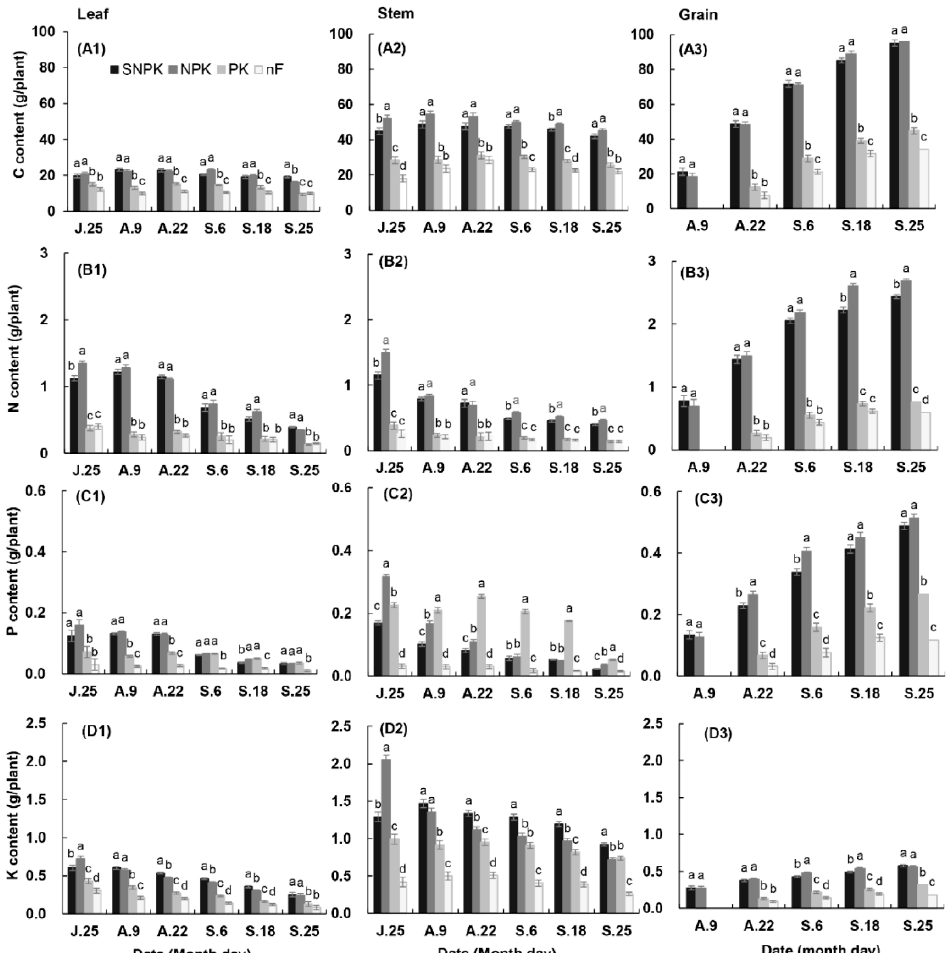
Figure 6. C, N, P, and K contents post-flowering in the leaf, stem, and grain in 2017 as the effect of long-term fertilizer treatment SNPK, NPK, PK, and nF. SNPK represents a combination of maize straw, chemical nitrogen, phosphorus, and potassium, NPK represents the treatment of chemical nitrogen, phosphorus, and potassium, PK represents chemical phosphorus and potassium, and nF represents no fertilizer. Values with the same letter are not significantly different at p < 0.05, comparison within the same measuring date. Bars: Standard error of the mean.